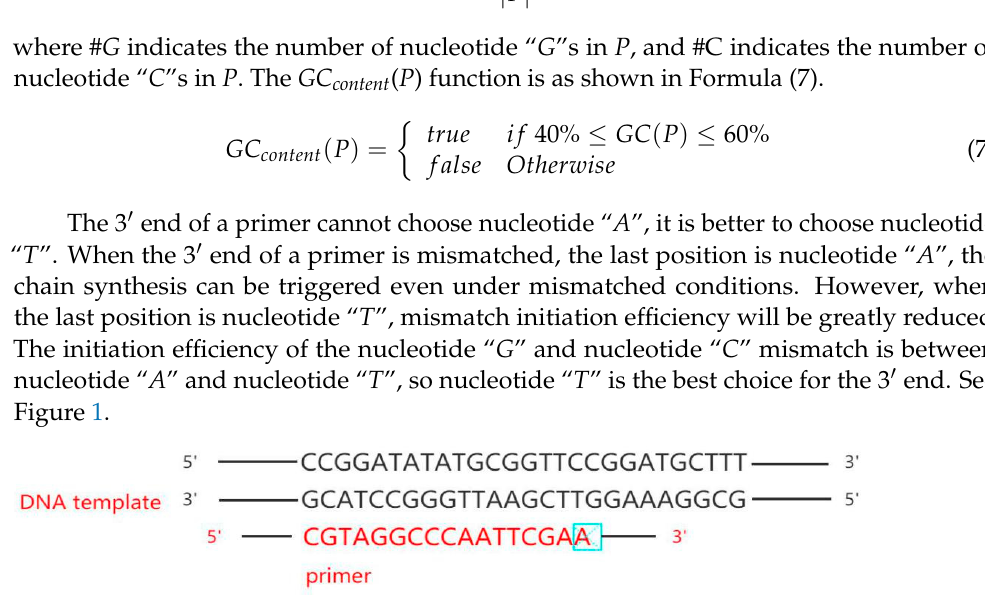
Figure 1. The value of the 3 ′ end of the primer.